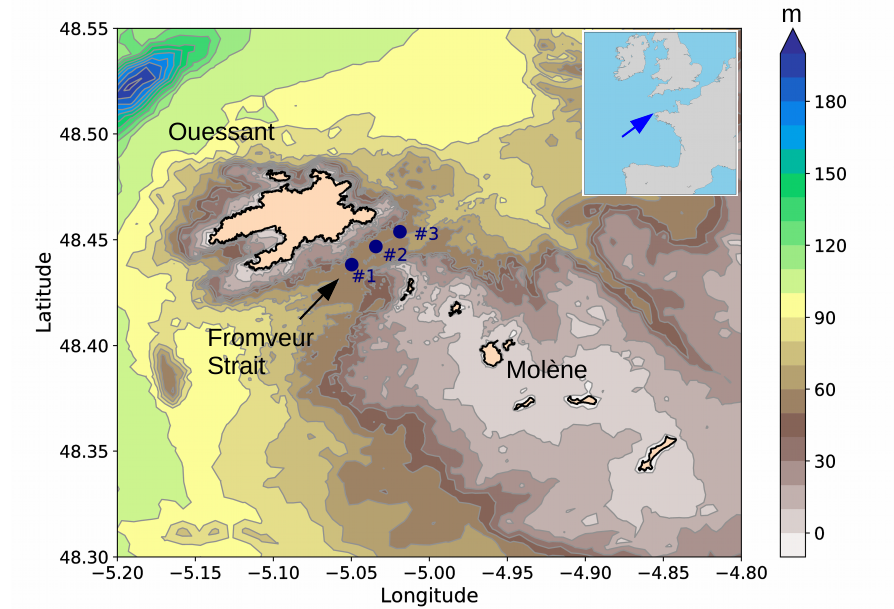
Figure 1. Bathymetry of Ouessant-Molène archipelago and the Fromveur Strait with the locations of the three points #1, #2 and #3 retained in the present